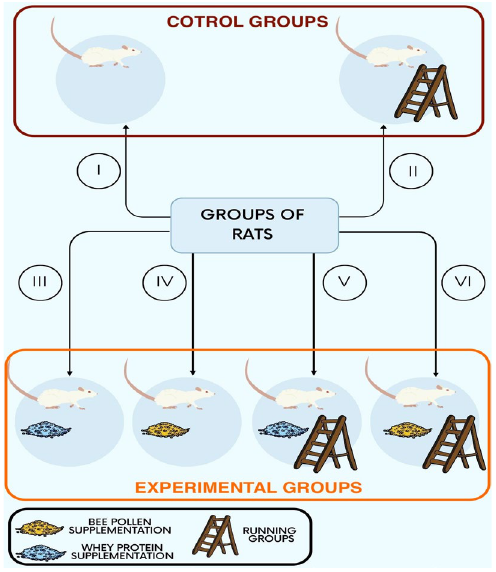
Figure 1. Schematic classification of rats into six groups (n = 5 per group)—two control groups without any supplementation and four experimental ones. The numbers correspond to the group numbers used on the diagram: I—non-running, non-supplemented group (control); II—running, non-supplemented group (control); III—non-running, whey-protein-supplemented group; IV—non-running, bee-pollen- supplemented group; V—running, whey-protein-supplemented group; VI—running, bee-pollen- supplemented